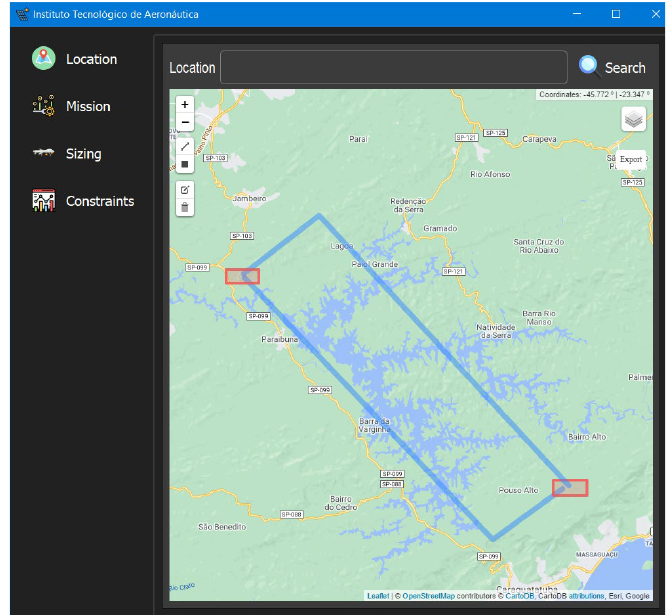
Figure 16. Definition of the place of operation.